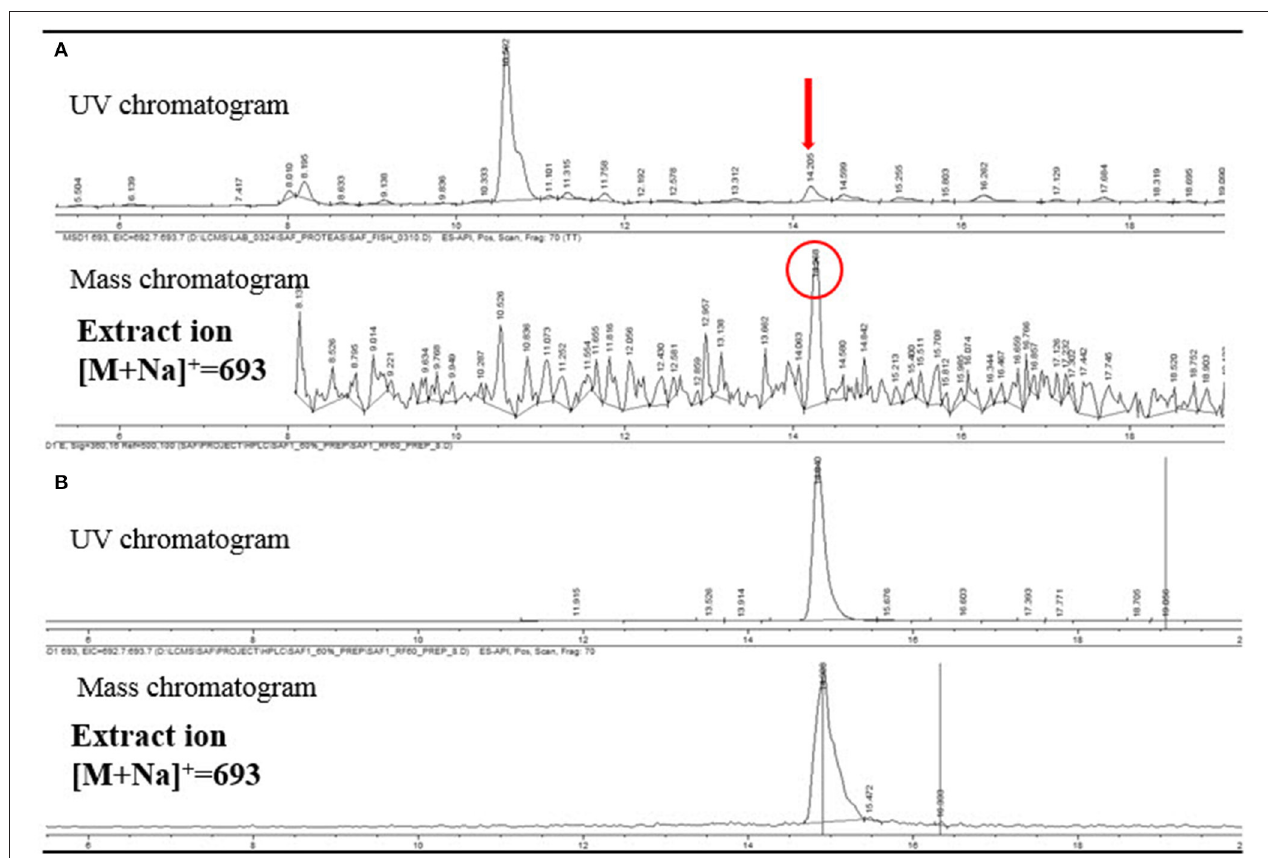
FIGURE 7 | (A) LC/MS analysis of the extract of a Protea infructescence specimen. UV chromatogram (upper) and mass chromatogram (lower). (B) LC/MS analysis of pure fungichromin (UV detection at 360